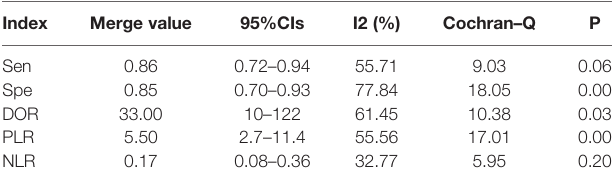
TABLE 3 | The combined predictive value of serum HE4 after third chemotherapy in 5 included